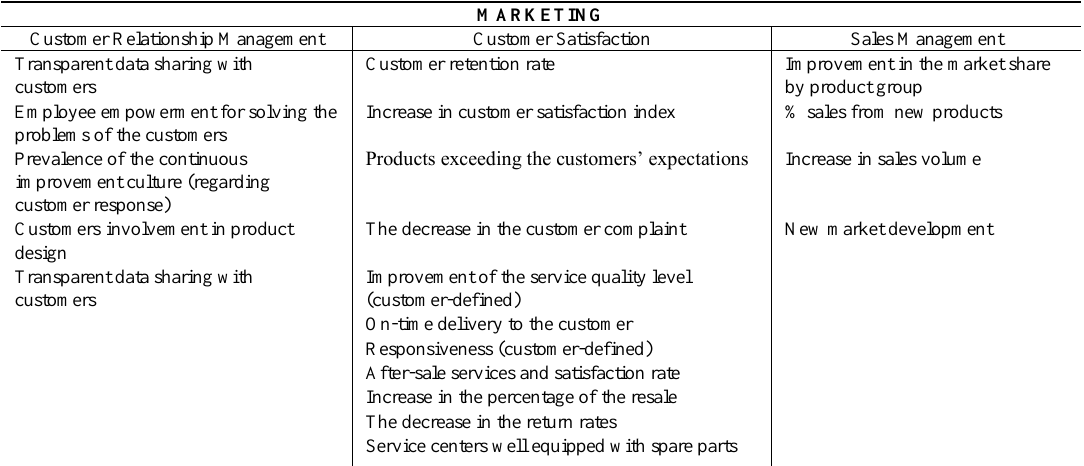
Table 5. Sub-criteria and measures for the marketing main